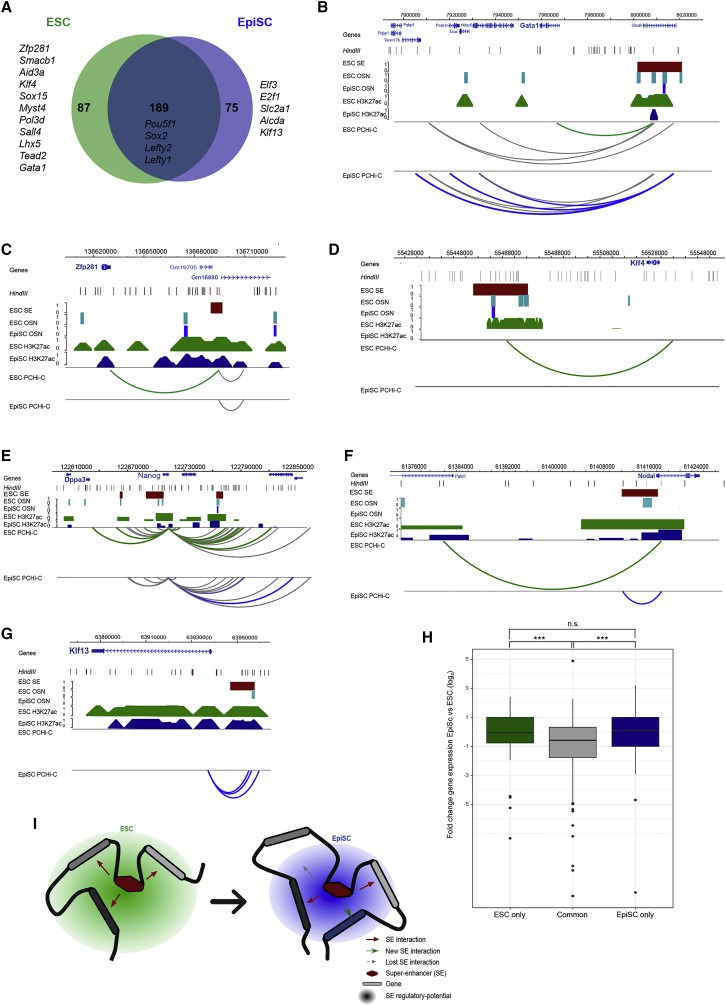
Pluripotent State-Specific Wiring of SE Interactions(A) The promoters in close physical proximity to ESC SEs were largely maintained in EpiSCs, but subsets of significant SE interactions were detected uniquely in each cell type.(B–G) Differences in the SE interactome between ESCs and EpiSCs are shown for the Gata1 (B), Zfp281 (C), Klf4 (D), Nanog (E), Nodal (F), and Klf13 (G) loci. Arcs indicate significant interactions colored by cell-type specificity (ESC only, green; EpiSC only, blue; shared, gray).(H) Boxplot showing the log2 fold change in gene expression between EpiSCs and ESCs, for genes interacting with SEs only in ESCs, in ESCs and EpiSCs, and only in EpiSCs. ∗∗p < 0.01 (Mann-Whitney U test).(I) Model illustrating the rewiring of interactions between pluripotent states at an individual SE. The red arrows represent the physical contacts between promoters detected by PCHi-C, creating a spatial hub for potential SE regulation (green/blue circles). Upon transitioning to EpiSCs, some contacts are lost (gray arrow), while new ones are established (green arrow).See also Figure S2 and Table S1.